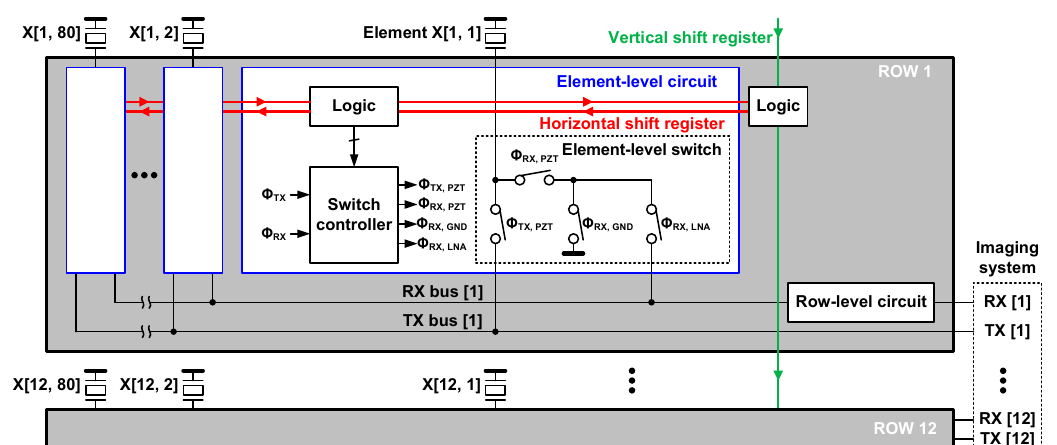
Figure 3. Block diagram of the second-generation ASIC.